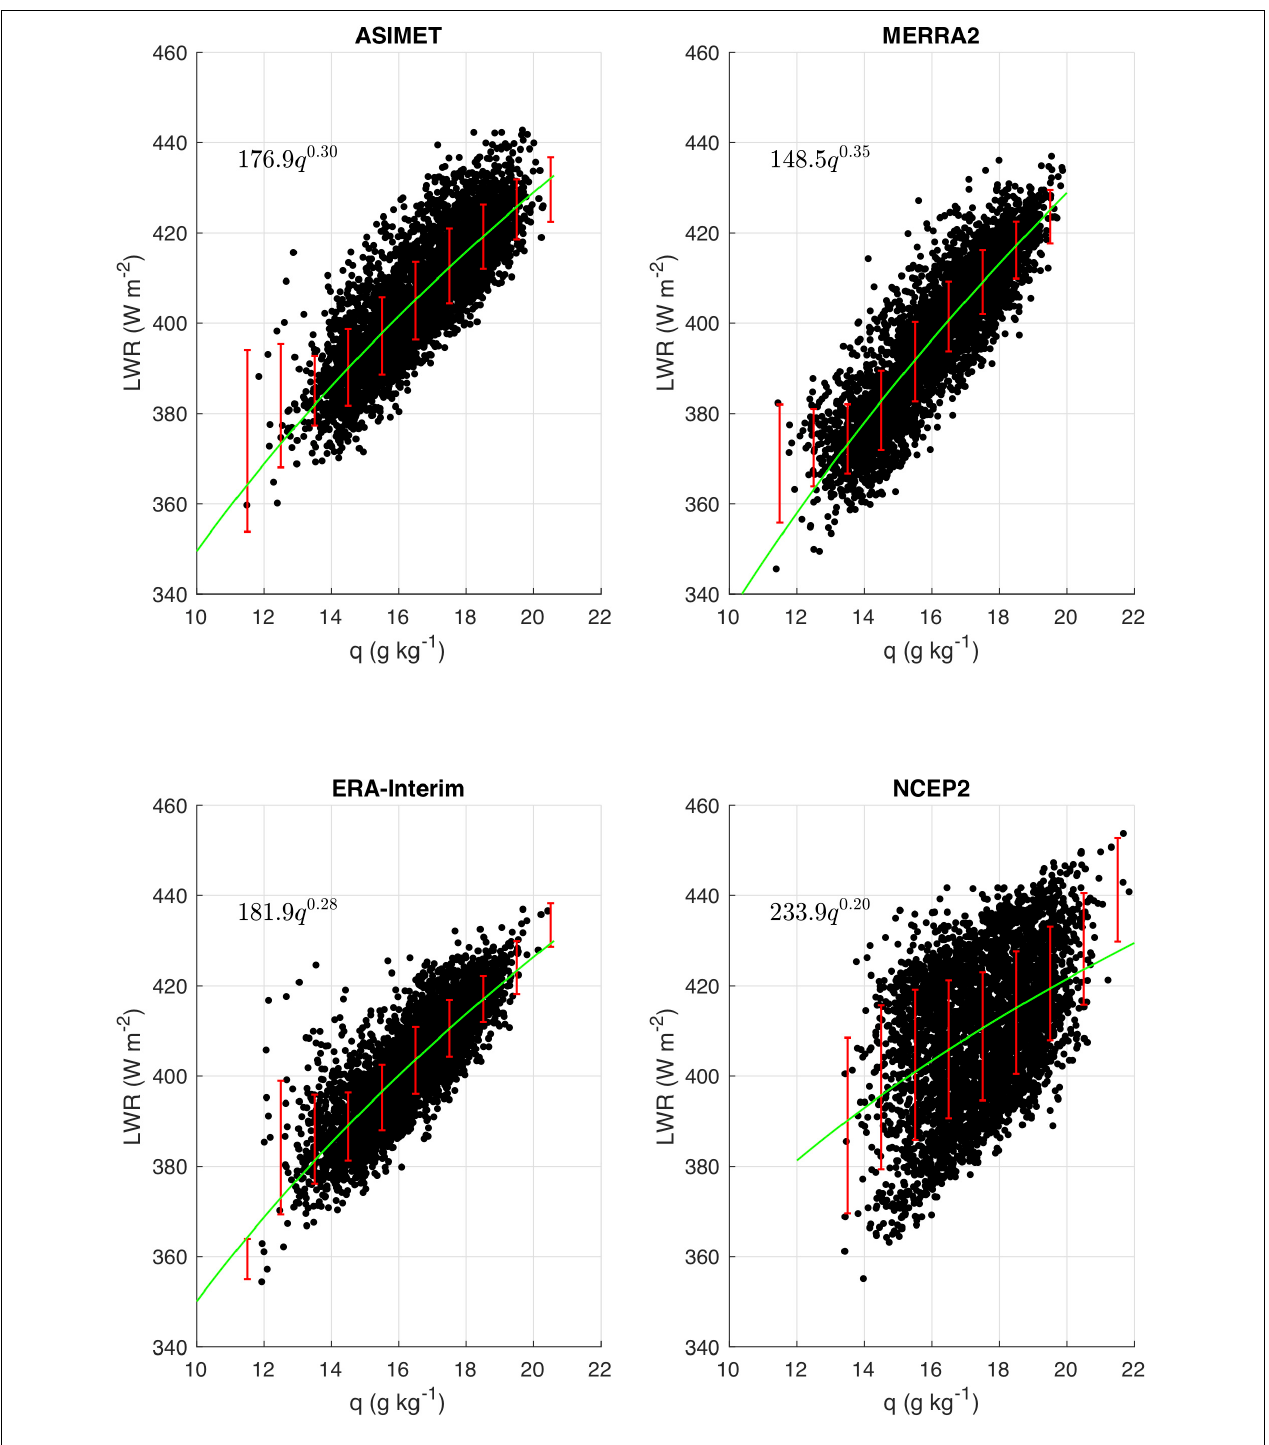
FIGURE 8 | Scatter plots of downward longwave radiation vs. specific humidity using daily averages between 2002 and 2012 (black dots). Power law fits to the daily values (green lines and annotations). Mean and one standard deviation in 1 g kg - 1 bins (red lines).